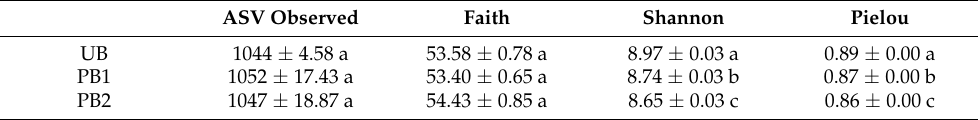
Table 3. Diversity index results expressed as mean ± standard deviation for each experimental burned (PB1 and PB2) and unburned plots (UB). ASV